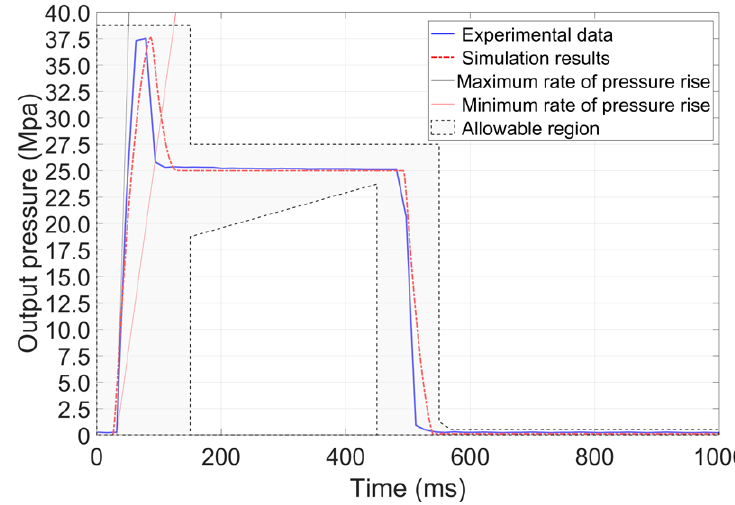
Figure 10. Experimental results for one period.